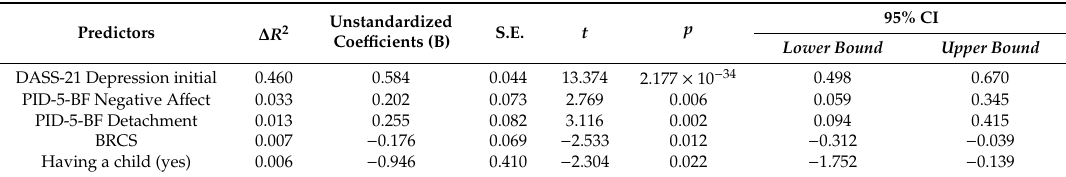
Table 3. Multiple Linear Regression Model Predicting the DASS-21 Depression Subscale Score During the Final Period of the Lockdown.